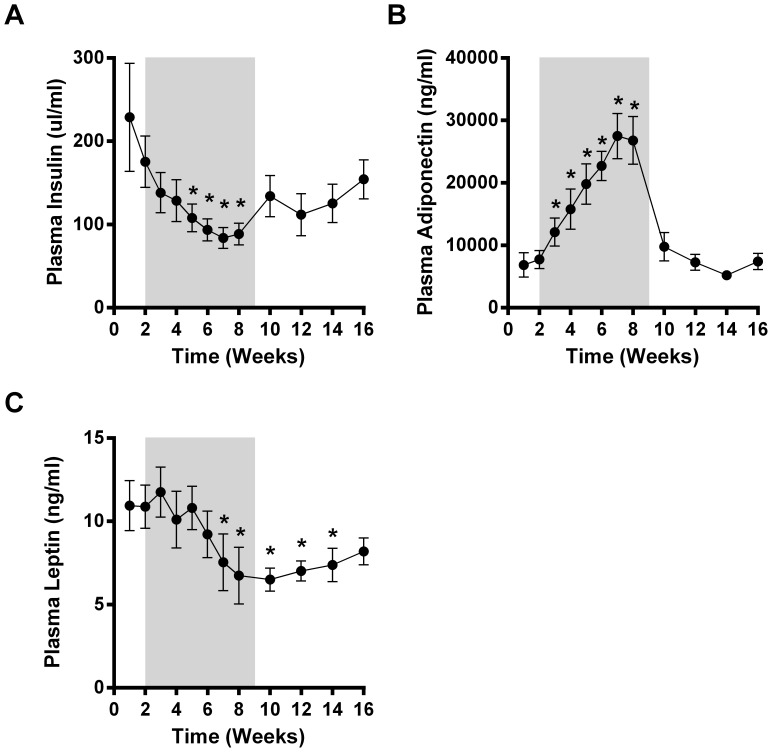
Prominent hormones such as insulin (A), leptin (B) and adiponectin (C) were found to be regulated by LY2405319.Differences considered significant (p<0.05) are denoted by *.